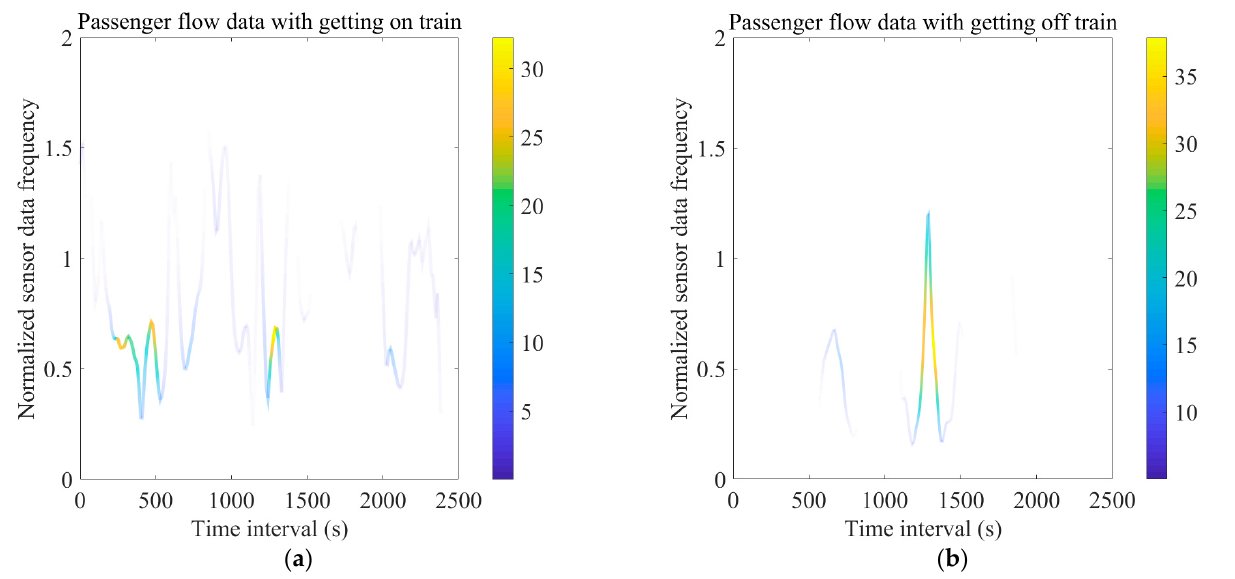
Figure 8. Passenger flow data in different states: ( a ) passenger flow data embarking on the train; ( b ) Passenger flow data disembarking from the train.